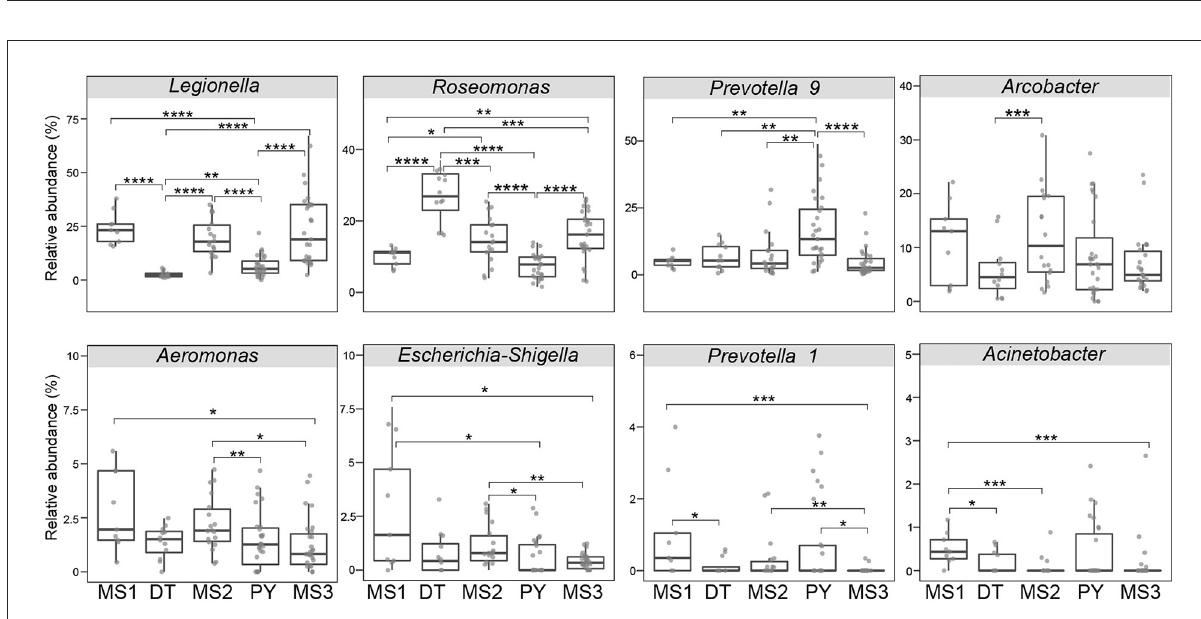
FIGURE5 Relative abundance of major abundant pathogen genera in different sections. The asterisk represents a significant difference between the two groups, * p < 0.05, ** p < 0.01, *** p < 0.001, **** p < 0.0001. DT, Dongting Lake; PY, Poyang Lake; MS, mainstream.